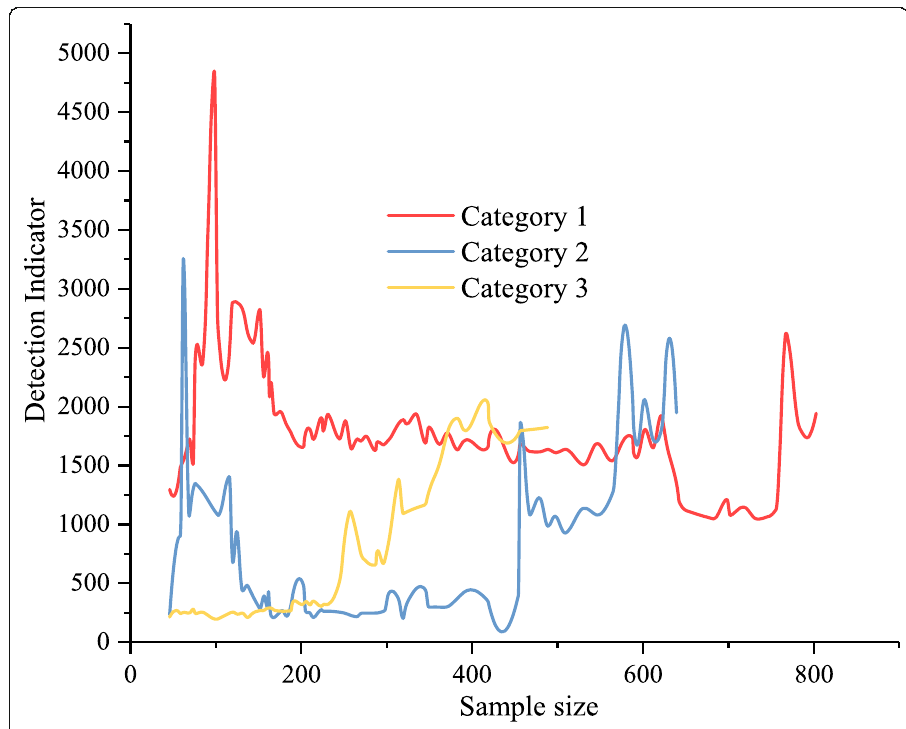
Fig. 9 The comparison curve of noise immunity simulation